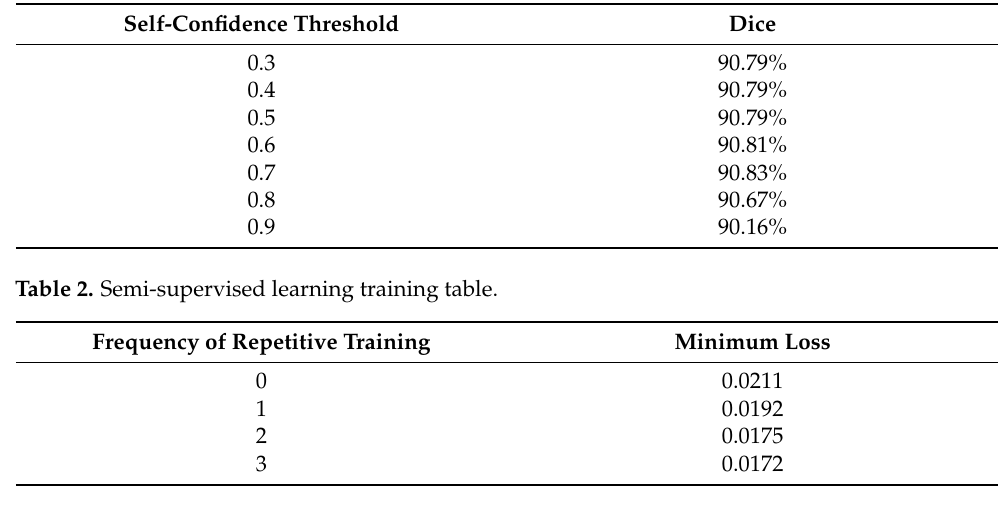
Figure 18. Schematic diagram of the pseudo label. ( a ) Input image; ( b ) Predicted image; ( c ) Pseudo label image; ( d ) Difference image. Table 1. Optimum threshold table.